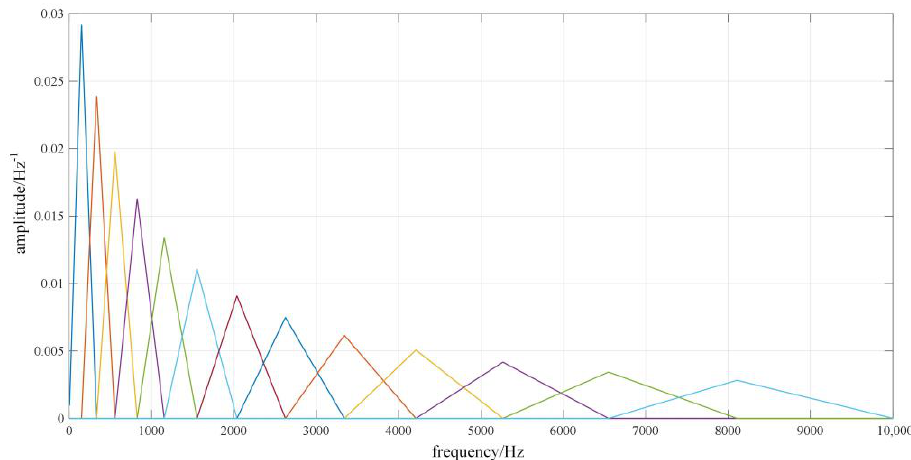
Figure 2. Non-equal-height Mel filter bank diagram.